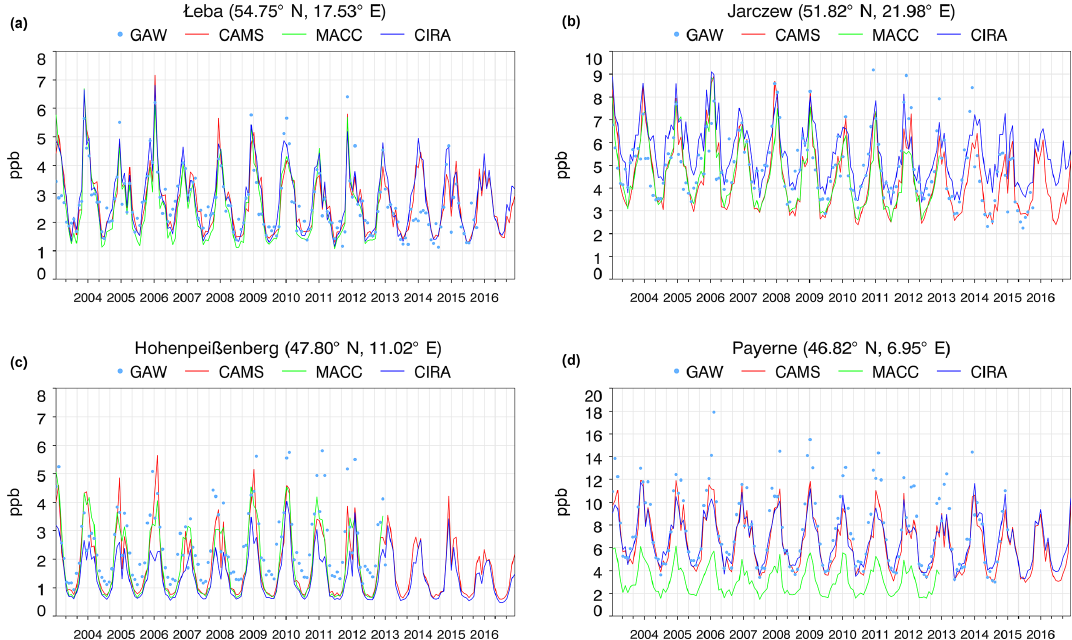
Figure 19. Time series of monthly mean surface NO 2 from CAMSRA (red), CIRA (blue), MACCRA (green) and GAW surface observations (blue dots) for (a) Łeba, (b) Jarczew, (c) Hohenpeißenberg and (d) Payerne (in ppb). The latitude and longitude of the stations are given in the plot